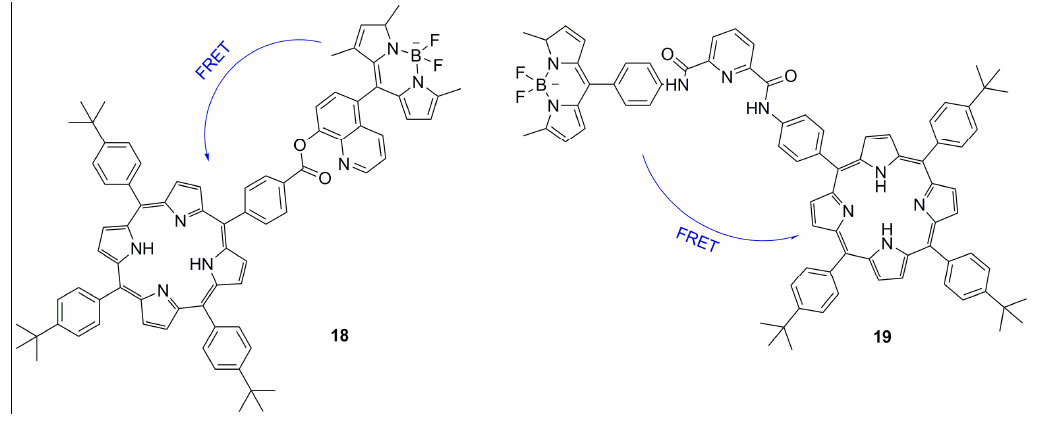
Figure 6. Schematic of naphthalimide–porphyrin hybrid for the ratiometric detection of Hg 2+ ion. Reproduced from ref. [38].